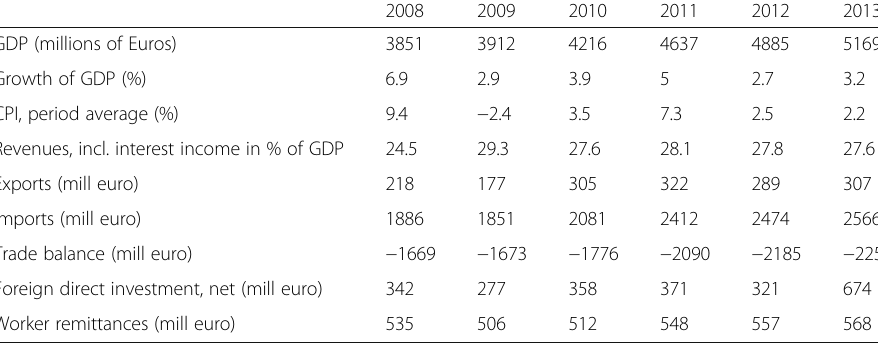
Table 1 Main economic indicators of